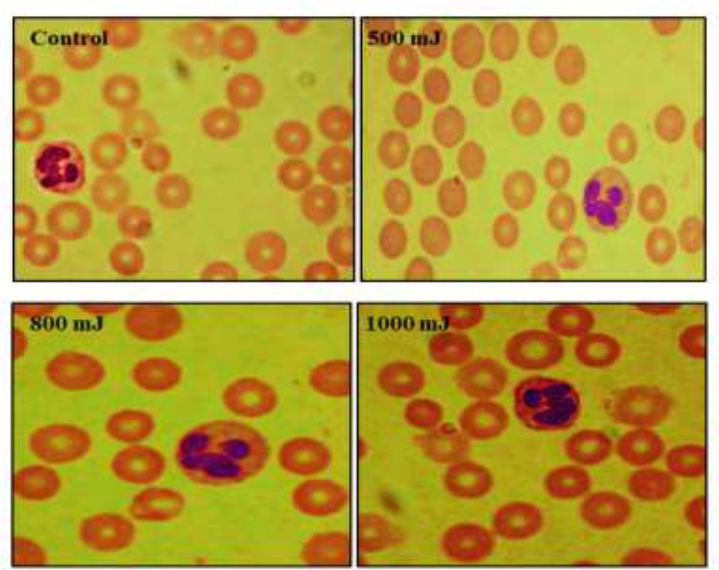
Figure 12: Morphology of a blood sample in the control group and treatment of Al 2 O 3 NPS at different energy (500, 800, and 1000)